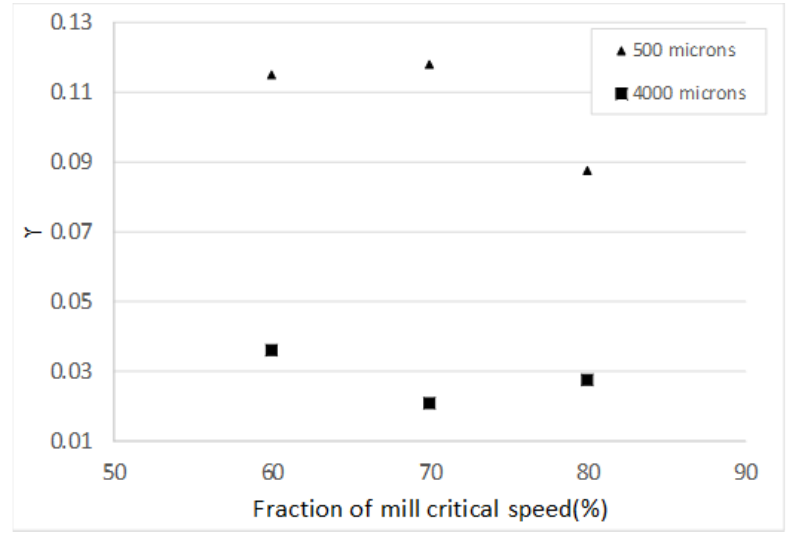
Figure 7. Variation of γ with mill speed.